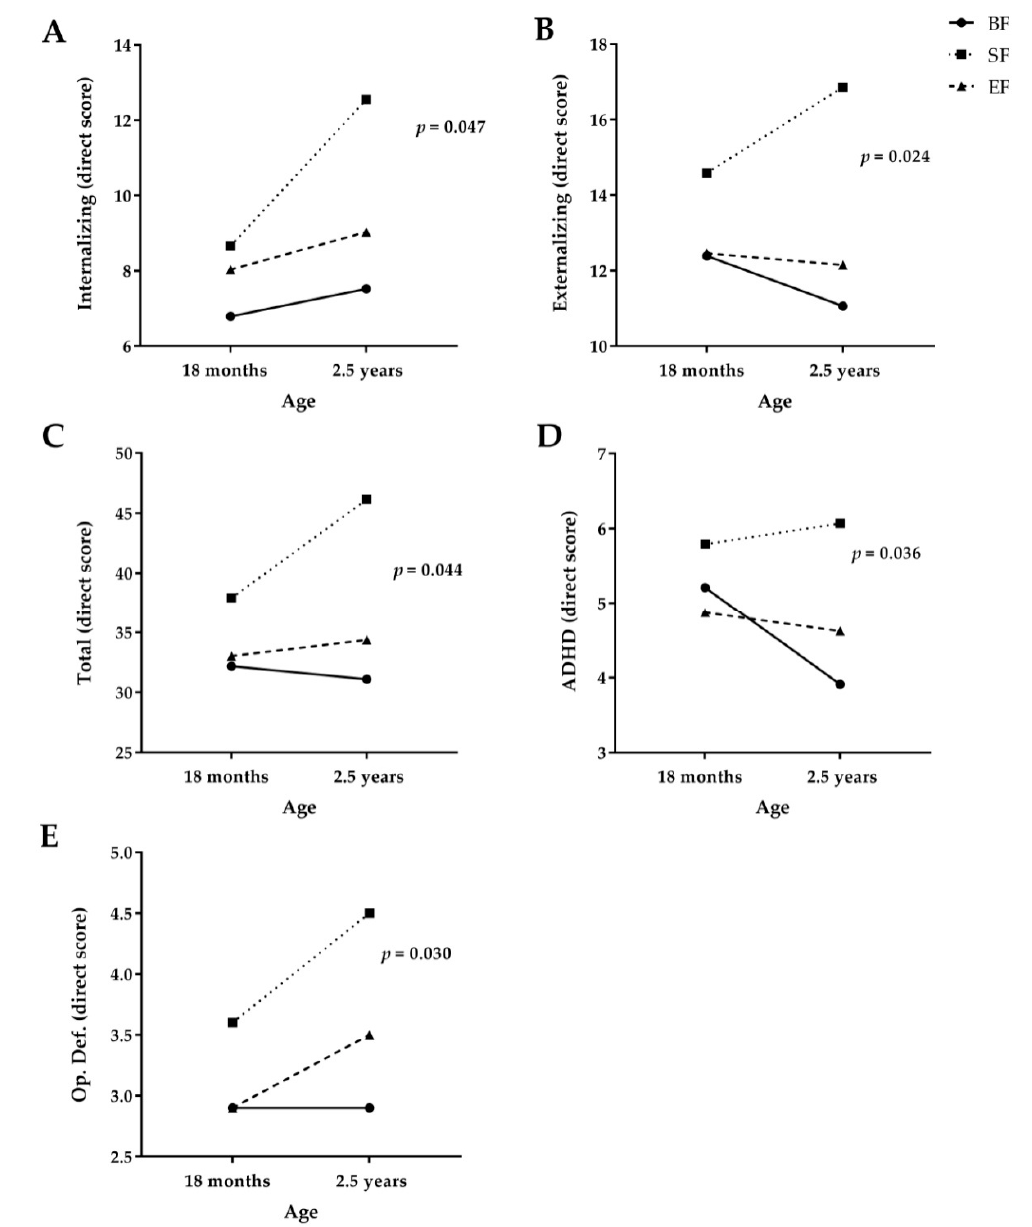
Figure 2. Longitudinal study of CBCL Scales at 18 months and 2.5 years old. ADHD, attention deficit / hyperactivity disorders; BF, breastfeeding; SF, standard infant formula; EF, experimental infant formula; Op. Def, oppositional defiant. Generalized linear mixed model of repeated measures for direct scores for Internalizing Problems ( A ), Externalizing Problems ( B ), Total Problems ( C ), ADHD ( D ), and Oppositional Defiant Problems ( E ) in COGNIS participants. Mean normative values: total problems = 33.5; externalizing problems = 14; internalizing problems = 9; ADHD = 5.5 and oppositional defiant problems = 4 [33].